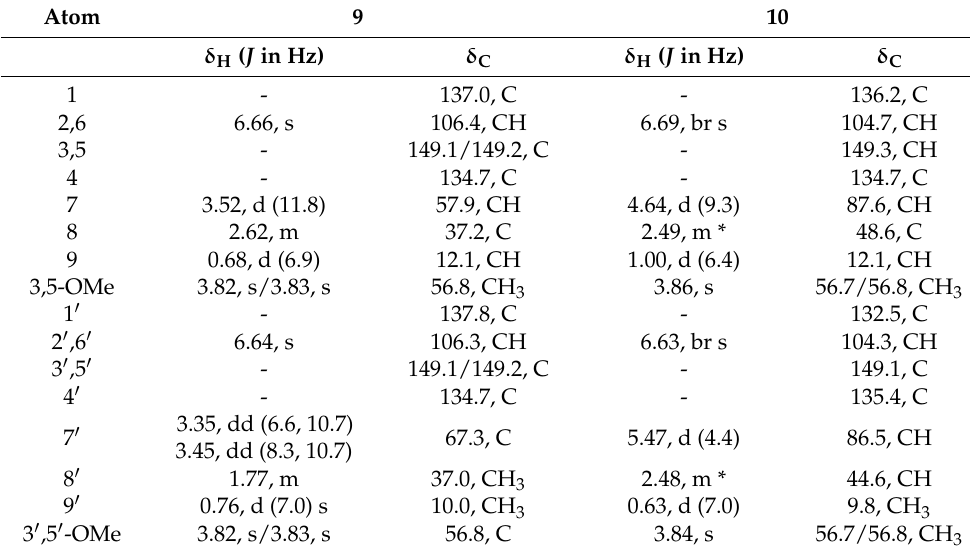
Table 4. The 1 H and 13 C NMR data for compounds 9 and 10 in CD 3